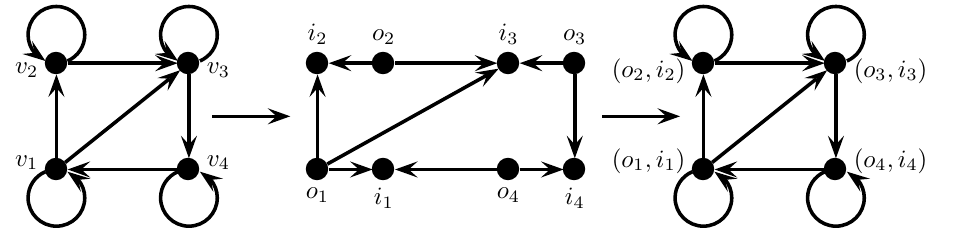
Fig. 2: From left to right: D , G = Split( D ) , and H = Join( G, M ) for M = { out( V ) → in( v ) | v ∈ V ( D ) } . Again, we write i x and o x to denote the vertices in( v x ) and out( v x ) of G , respectively. Note that the function f of Lemma 4 is an isomorphism between D and H